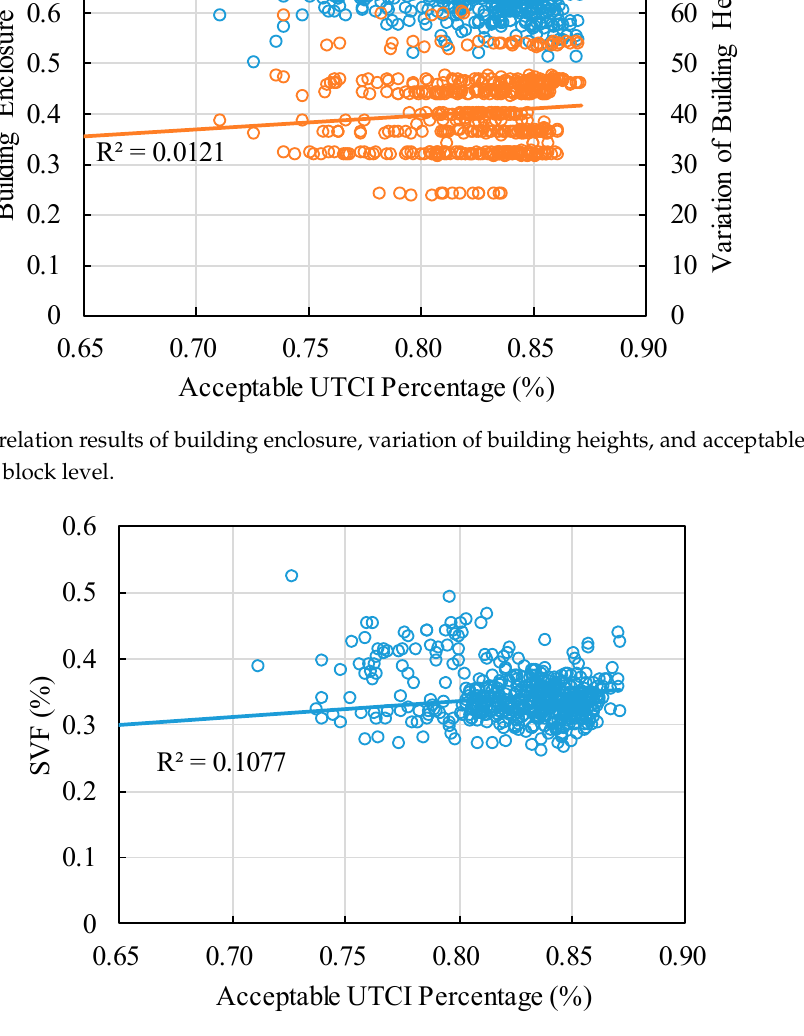
Figure 10. Correlation results of building density, plot ratio, and acceptable UTCI percentage at block level.